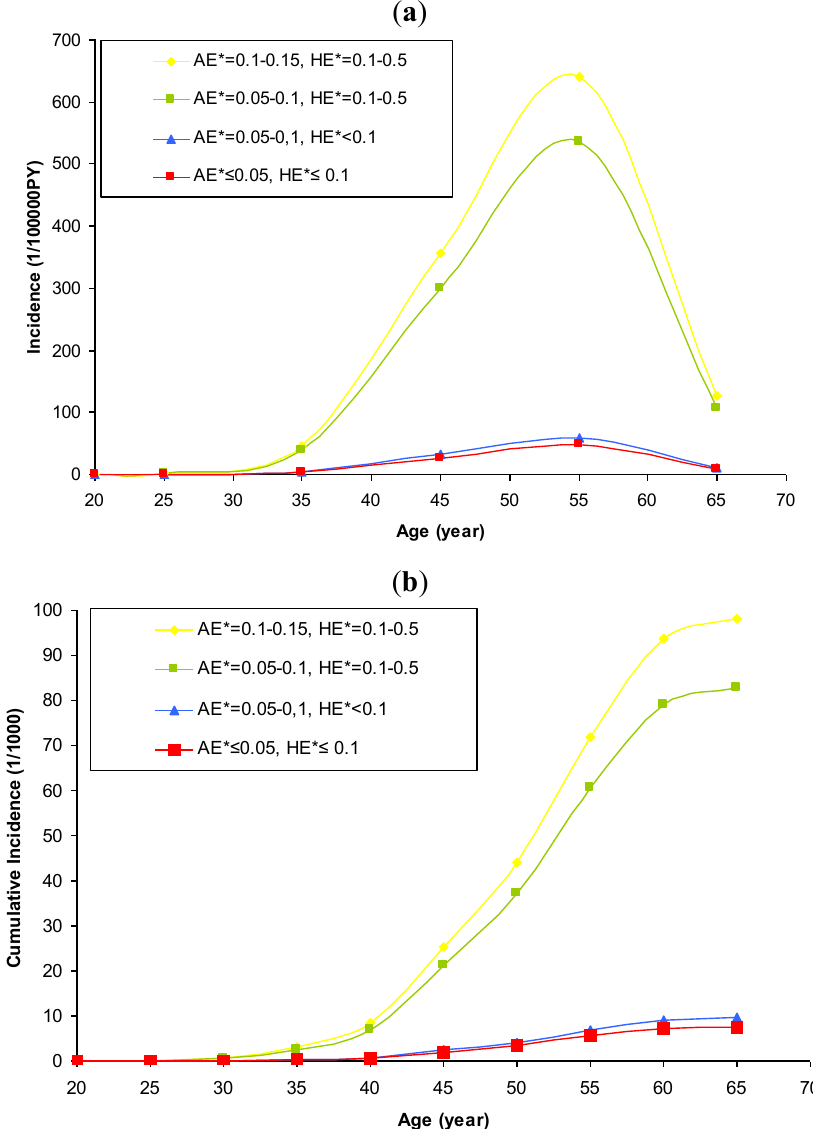
Figure 2. Exposure-response relationship between respirable crystalline silica dust exposure and silicosis over time (both gender, non-smoker). ( a ) Estimated incidence density of silicosis; and ( b ) Estimated cumulative incidence of